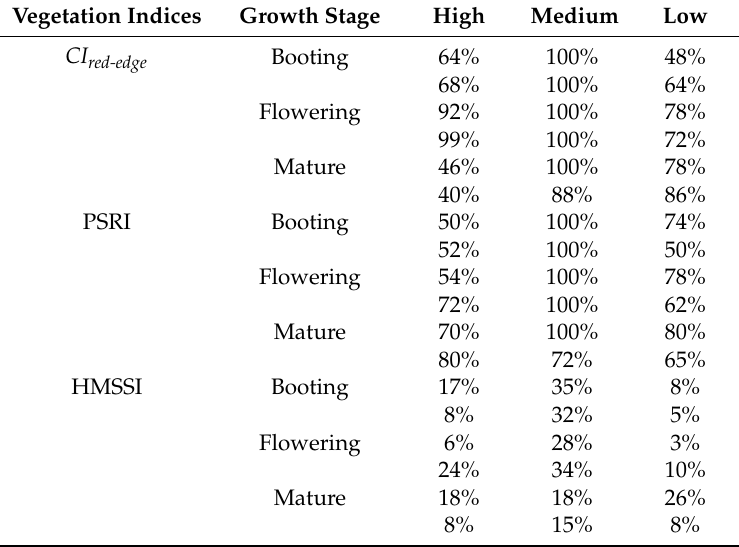
Table 3. Misjudgement rates of the three indices at different growth